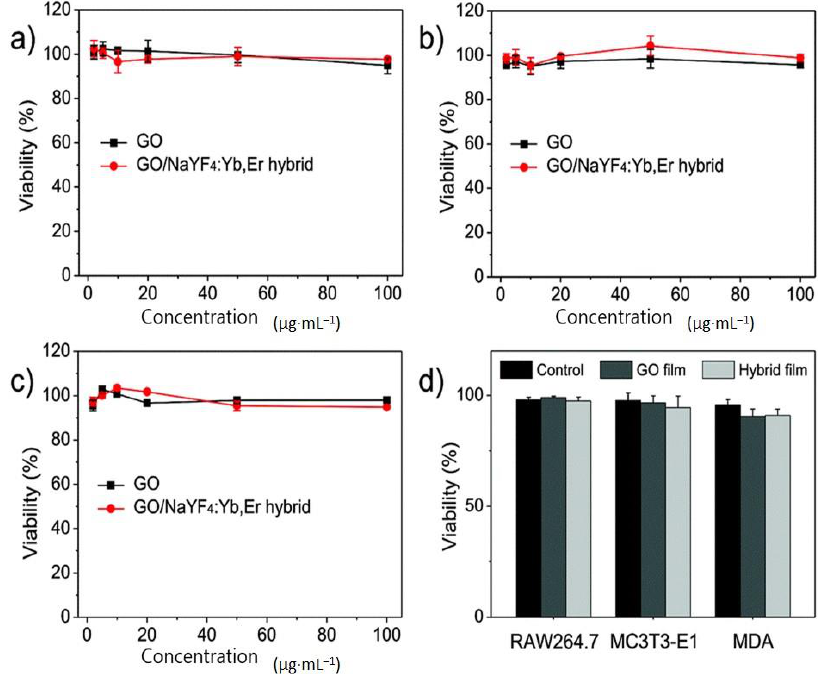
Figure 10. Biocompatibility of graphene oxide-PEI-NaYF 4 :Er 3+ /Yb 3+ hybrid and hybrid film. ( a – c ) In vitro relative cellular viability of three types of cells (RAW264.7, MC3T3-E1 and MDA) treated with graphene oxide and the graphene oxide–NaYF 4 :Er 3+ /Yb 3+ hybrid, respectively. ( d ) Cytotoxicity of pure graphene oxide and graphene oxide–NaYF 4 :Er 3+ /Yb 3+ films (reproduced from Ref. [32] with permission from the PCCP Owner Societies).